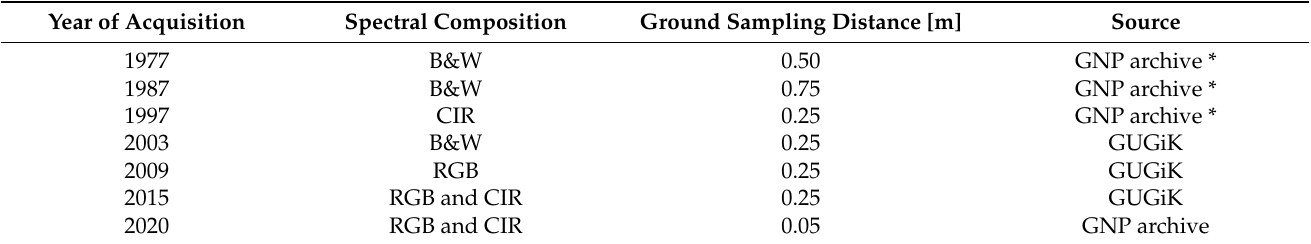
Table 1. A list of aerial orthophoto sets (B&W—Black and White; CIR—Color Infrared; RGB—Red, Green, Blue) used in the study. Datasets marked with * in the source column were generated from scanned copies of aerial